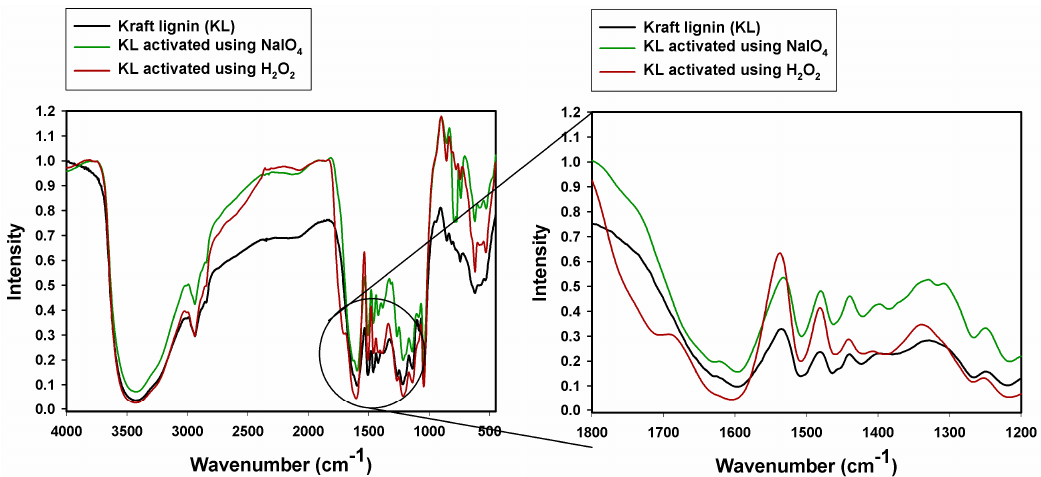
Figure 2. FTIR spectra of pure and activated kraft lignin.